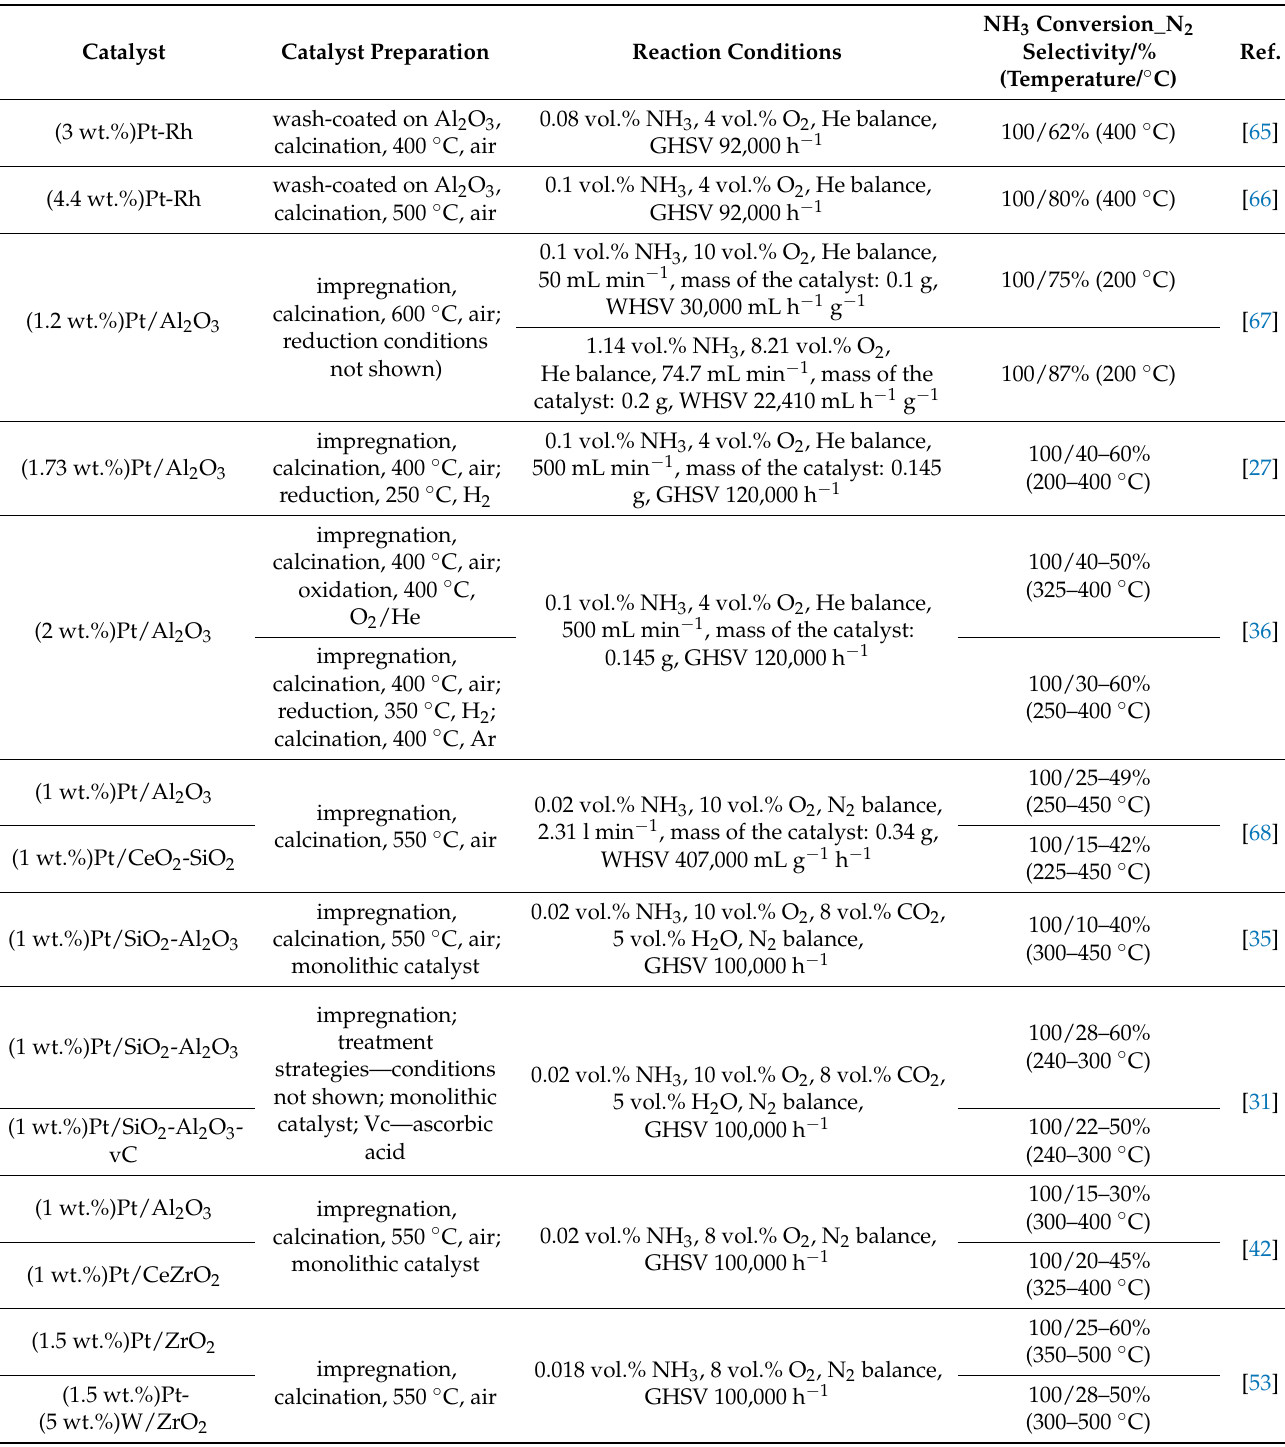
Table 1. Comparison of full NH 3 conversion and N 2 selectivity in same temperature range over Pt-based catalysts reported in